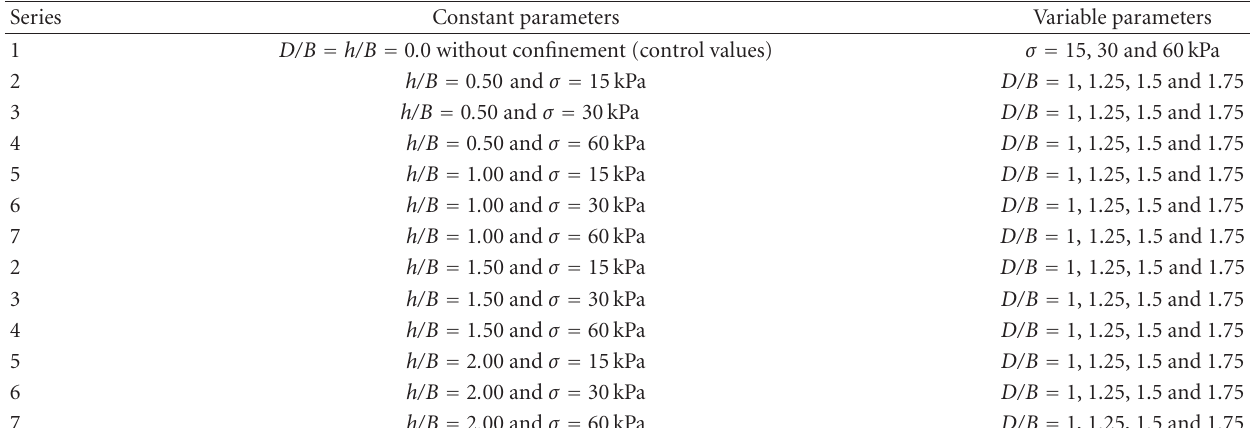
Table 1: Model tests program.